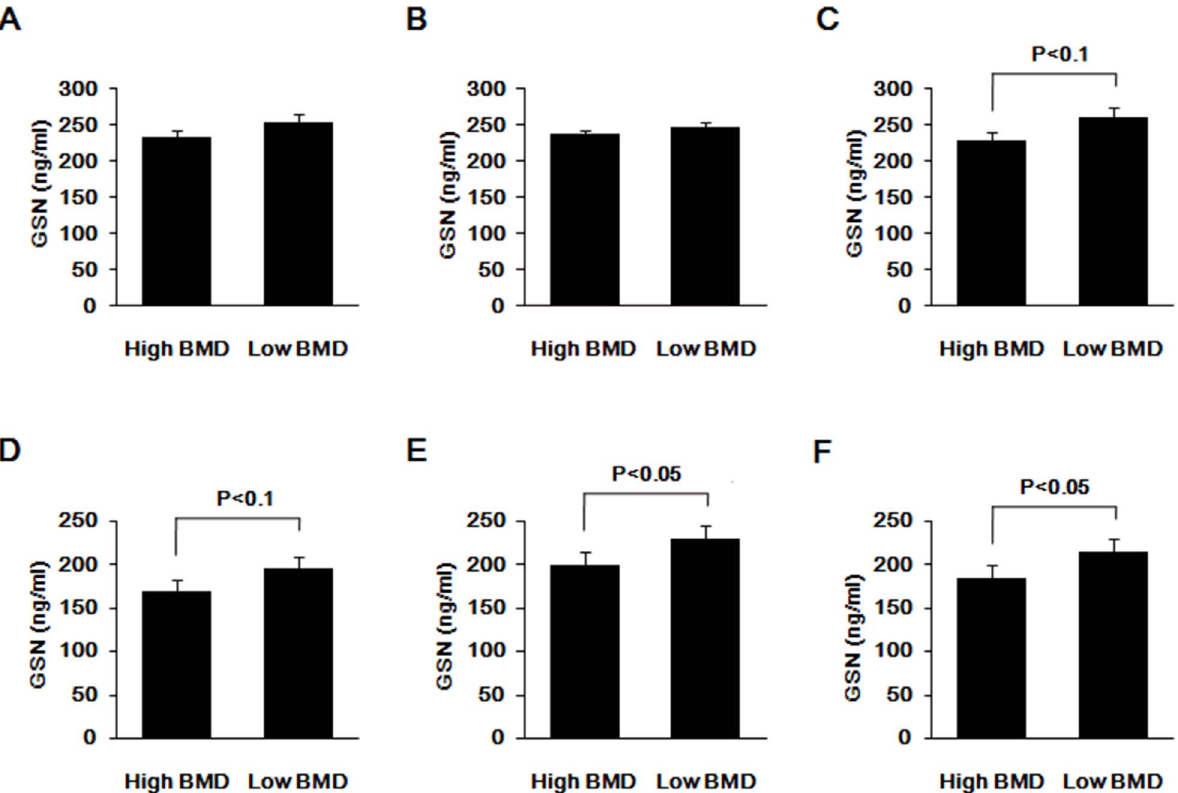
Fig 2. Difference in plasma GSN levels between subjects with extremely high and low BMD. A: Total subjects from the Subgroup1 B: Males from the Subgroup 1 C: Females from the Subgroup 1 D: Females in the Subgroup 2 E: Females in the Subgroup 3 F: Females pooled from the Subgroups 2 and 3. Due to the significant effects of age, BMI and P1NP on BMD, we adopted analysis of covariance to adjust the confounding effects for three Subgroups to compare whether there were statistical differences between high and low subjects. Data was described as mean ±